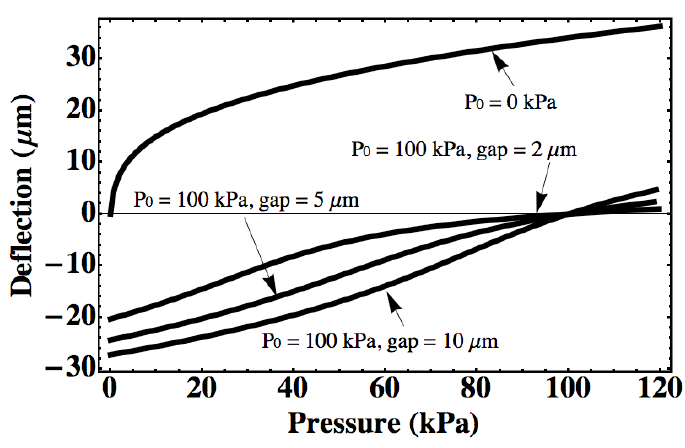
Figure 2. The deflection of diaphragm calculated by large-deflection model with different cavity gap and initial sealed gas pressure. The radius of the diaphragm is 1 mm, and the thickness is 5 μ m. The downward deflection is assumed positive, the upward deflection is assumed